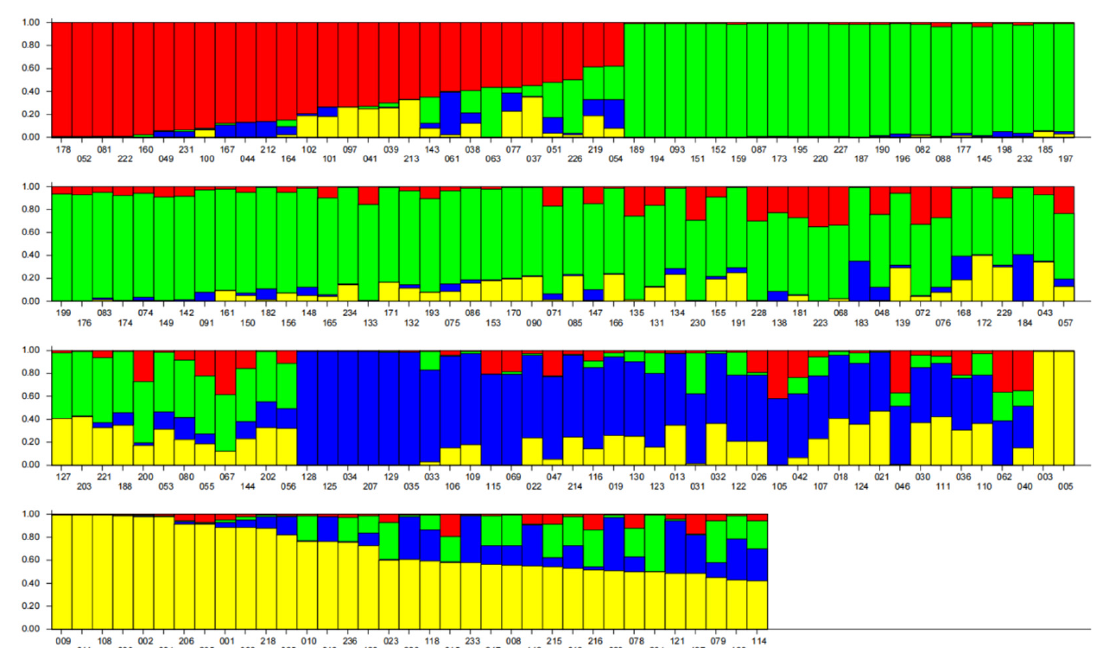
Figure 2. Four subgroups of 185 materials based on the Structure 2.5 hybrid model. Each rectangular bar represents one copy of the accession, and its probability of being classified into one of the four subpopulations can be determined by the length of the differently colored (red, yellow, green, blue) lines. Y-axes, Q value; X-axes, the ID of each accession (the same characters “11HX-” of each ID was omitted). Table 3. Marker loci associated with traits of soybean plant height, stem diameter, and their variation under low-light conditions, along with the explanation rates of different